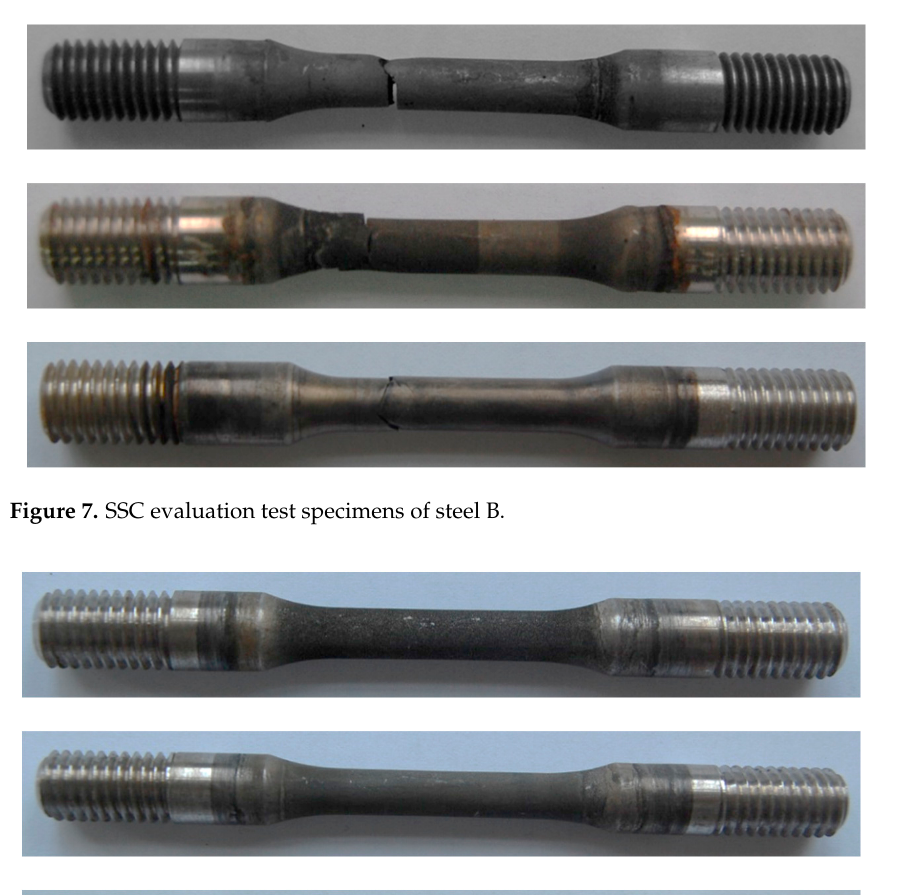
Figure 6. SSC evaluation test specimens of steel A.